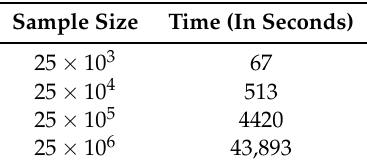
Table 1. Mean average running times (over 5 replicates) for different sample sizes (in log).